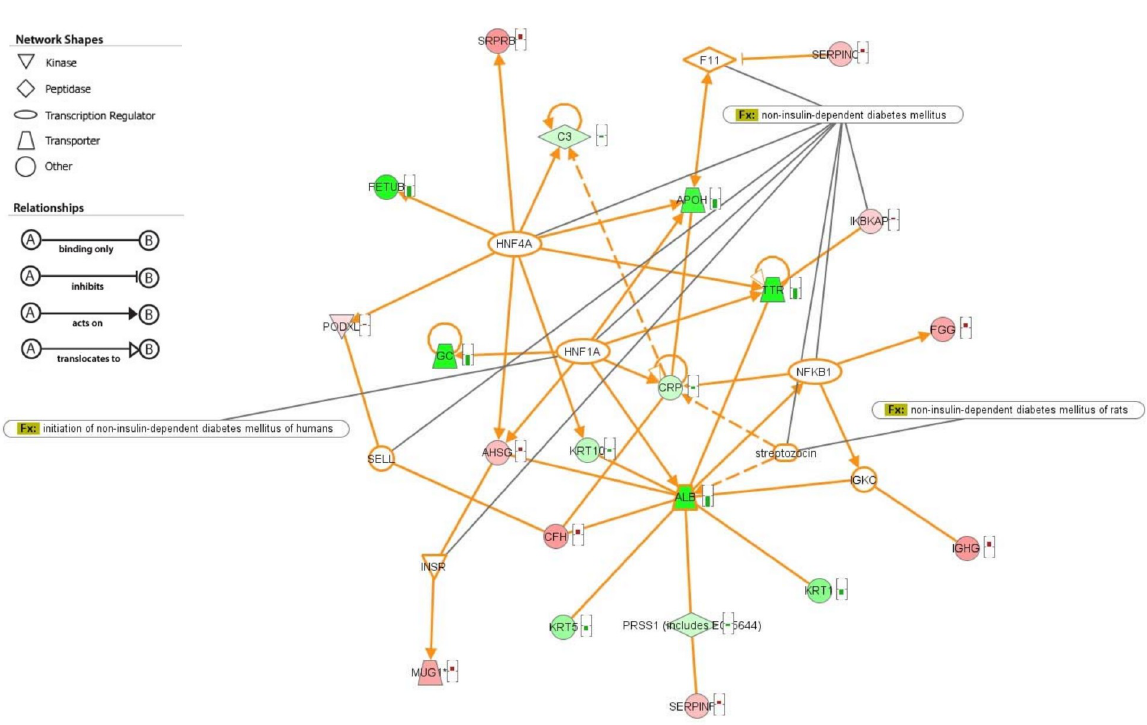
PLOS ONE | https://doi.org/10.1371/journal.pone.0206509 November5,